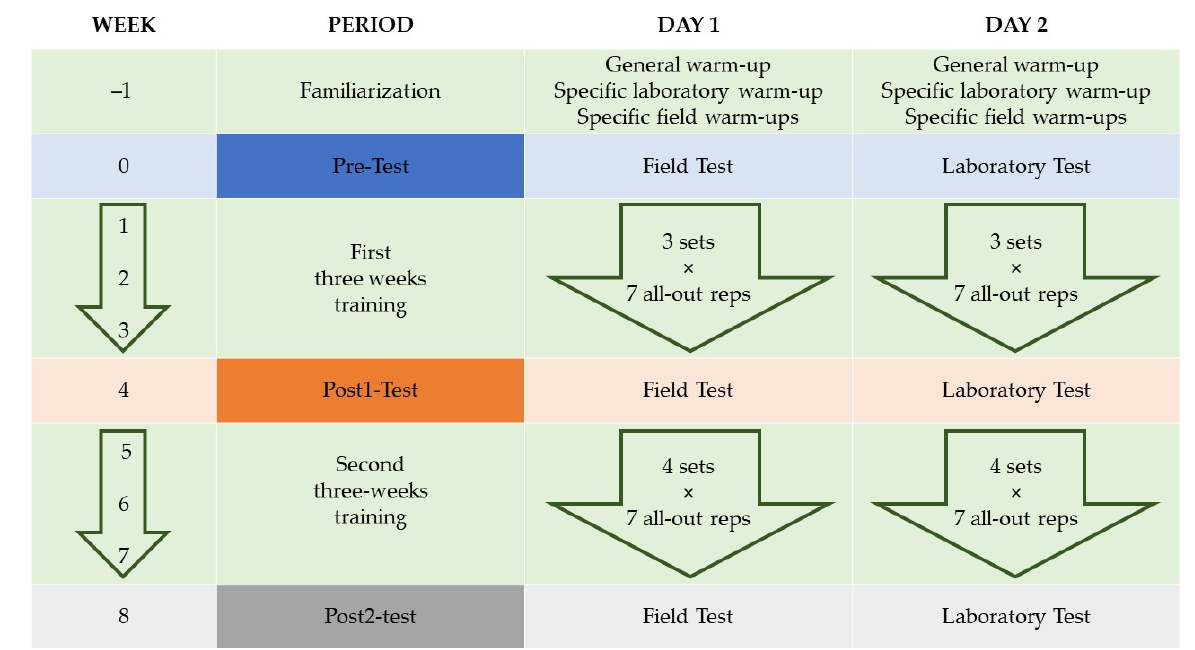
Figure 1. Experimental procedures.